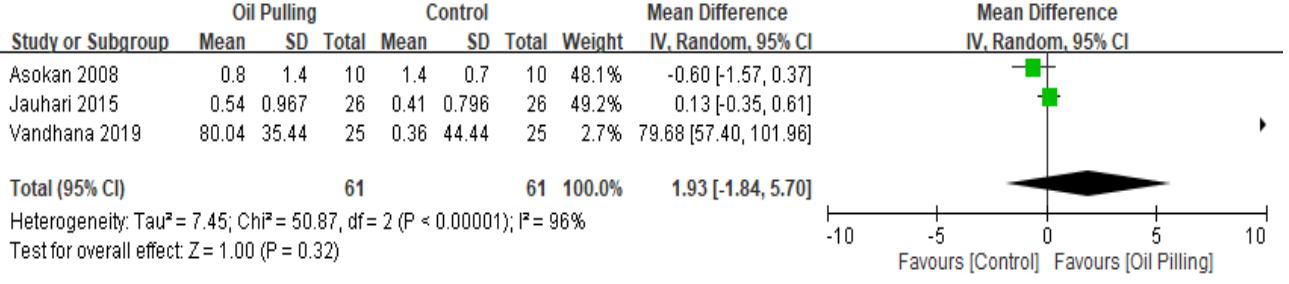
Figure 3. Forest plot for salivary Streptococcus mutans (SM) count.